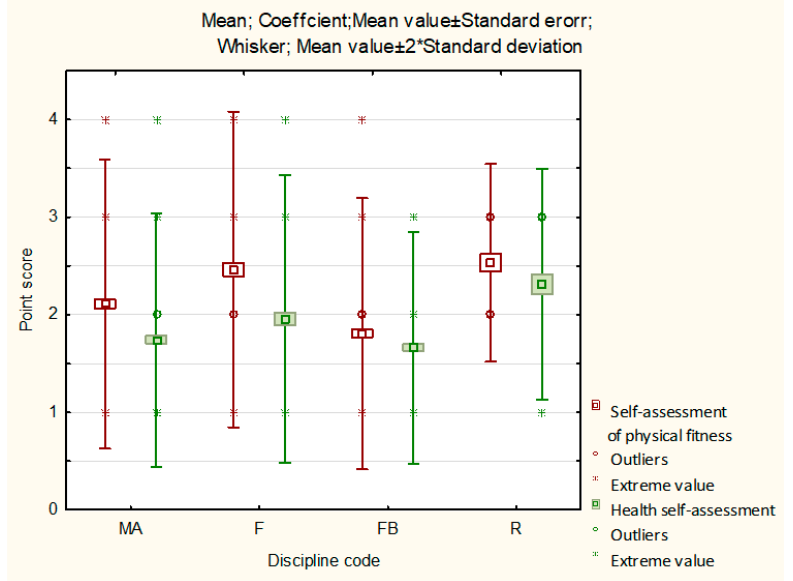
Figure 1. Descriptive statistics for self-assessment of physical fitness and health depending on the sports